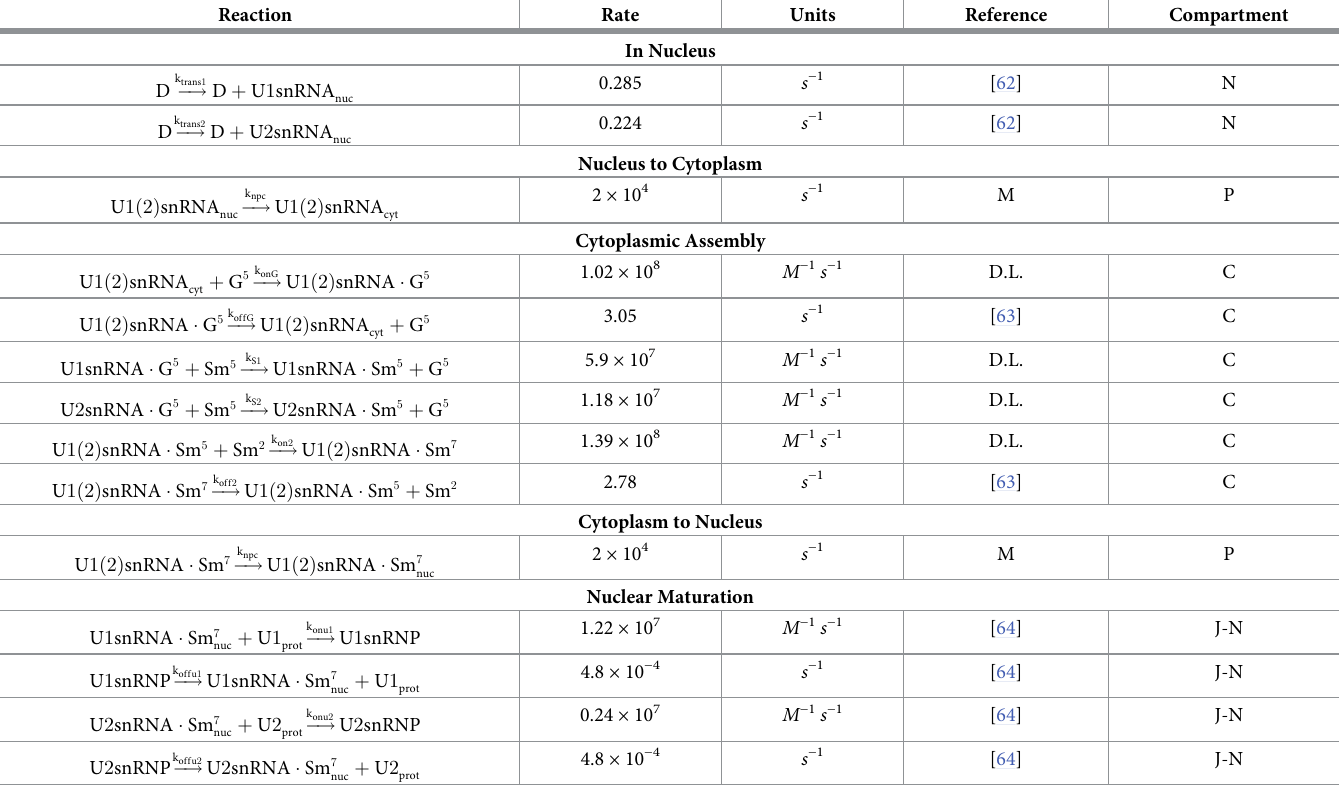
Table 2. Reactions describing U1 (u1snRNP) and U2 (U2snRNP) splicing particles formation together with their associated rates. Abbreviations are: DNA(D), Gemin 5( G 5 ), five already-assembled Sm proteins ( Sm 5 ), the remaining Sm proteins ( Sm 2 ), diffusion-limited (D.L.), model assumption (M), nucleus (N), NPC (P), Cajal bodies (J) and cytoplasm (C).